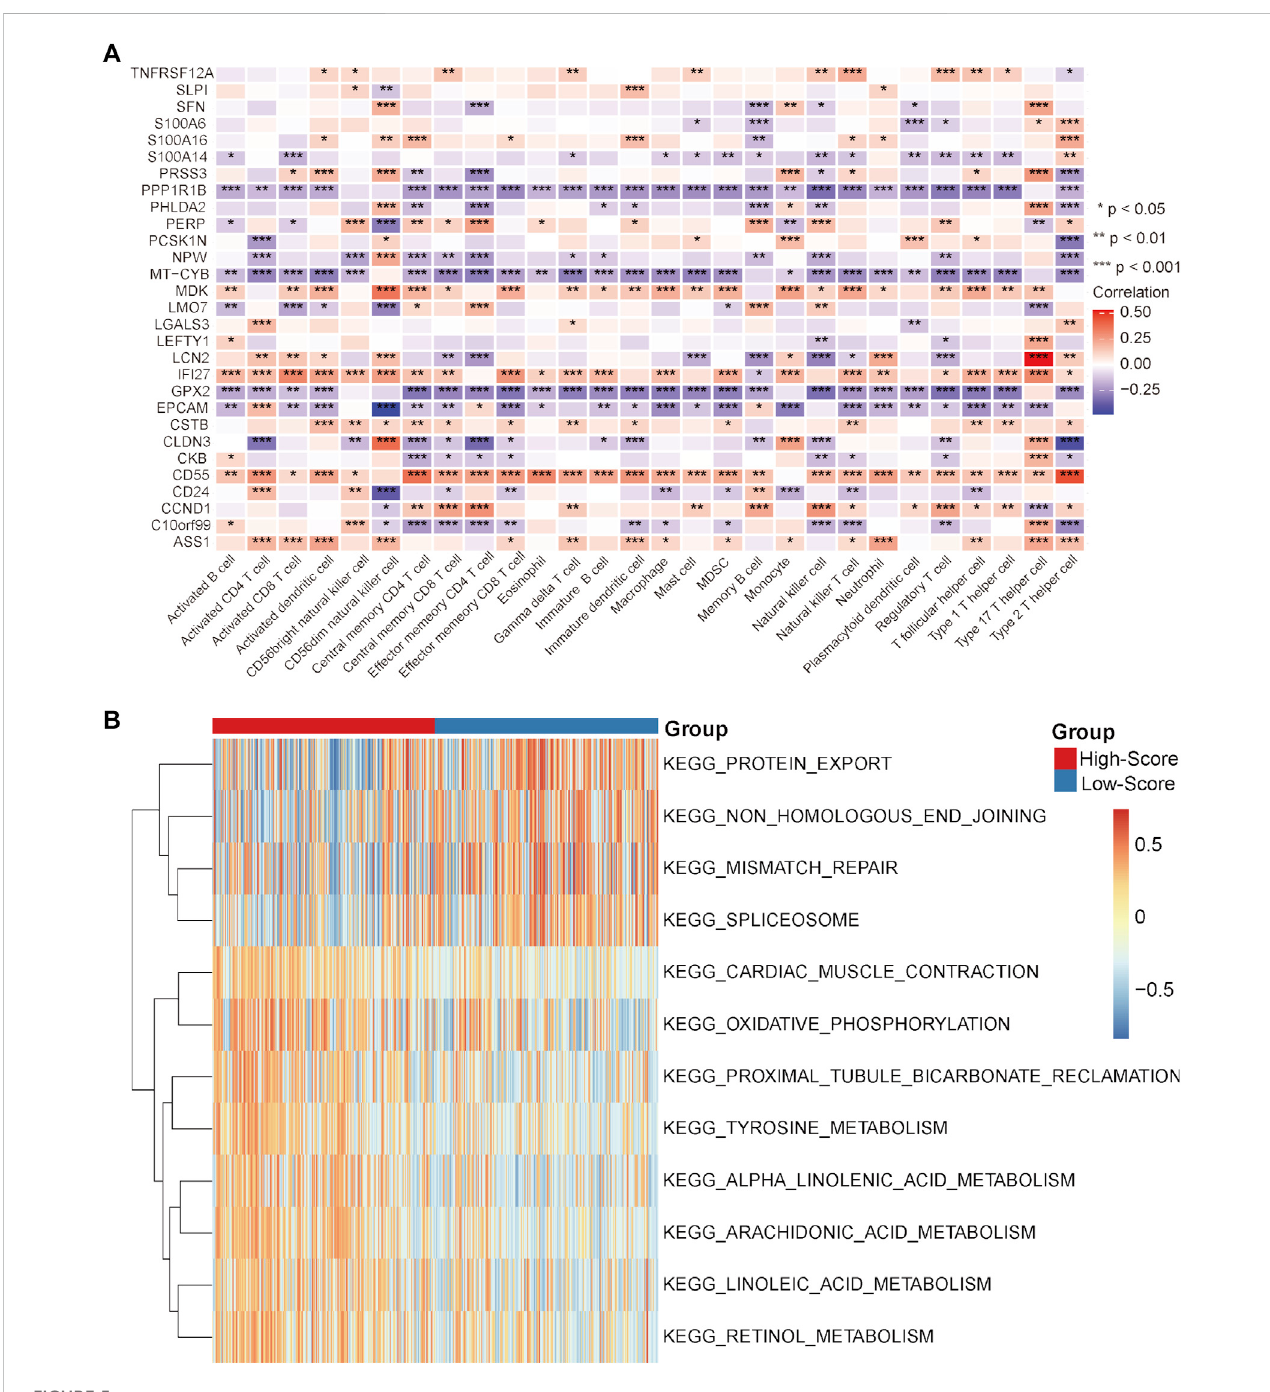
FIGURE 5 Correlation analysis and GSVA in the TCGA-CRC cohort. (A) Correlation heatmap between immune cells and single-cell marker genes. (B) GSVA heatmap between the high- and low-score groups. * p < 0.05, ** p < 0.01, *** p < 0.001, **** p < 0.0001, ns, not signi fi